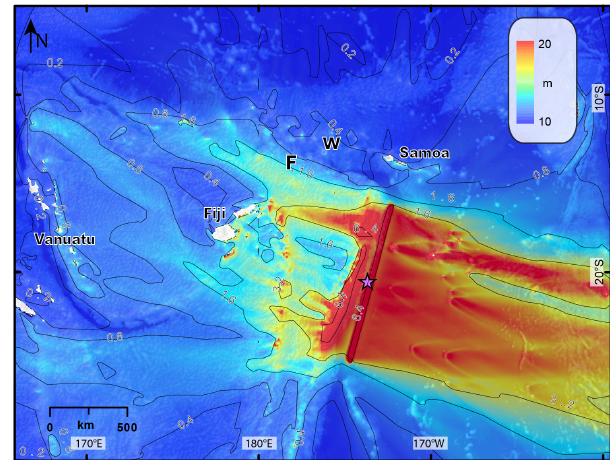
Figure 7. Maximum wave elevation at Futuna and Alofi modelled using the Gerris flow solver with an M w = 9.1 earthquake source along the Kuril Trench (Fig. 5; Sc. 1, Table 4). Insert: zoom on amplification area on west coast of Futuna.